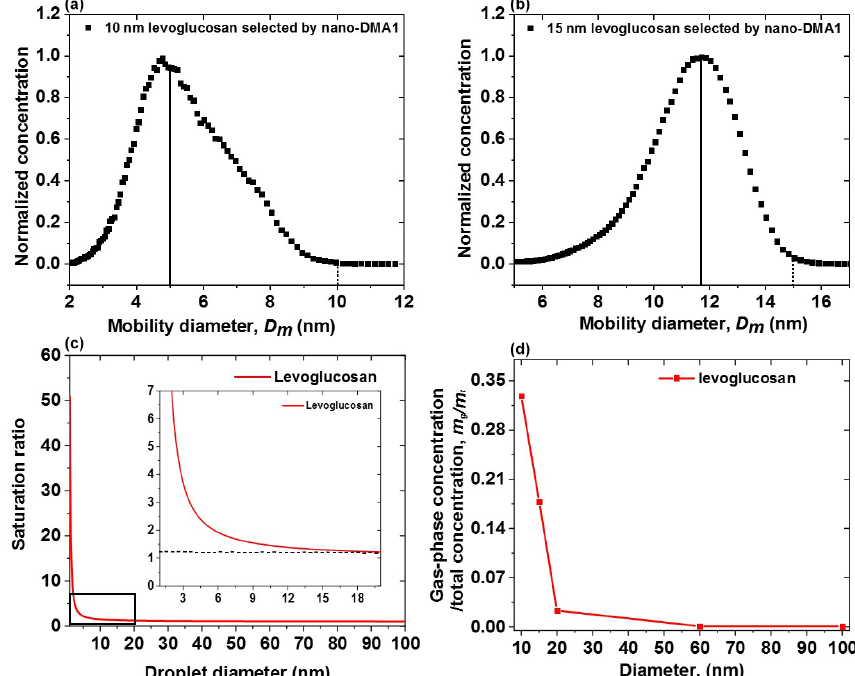
Figure 5. The normalized size distributions scanned by nano-DMA2 for (a) 10 and (b) 15nm levoglucosan at 10% at 298K. The dotted lines mark the diameters of the monodispersed nanoparticles selected by the nano-DMA1. The back solid lines mark the peak diameters from the normalized size distributions scanned by the nano-DMA2. (c) Vapor saturation ratio of levoglucosan as a function of nanodroplet diameter according to the Kelvin equation. The diameter range 1–20nm for the saturation ratio of levoglucosan particles is shown as an inset. The value of surface tension of pure levoglucosan is 0.0227104 [Jm − 2 ]. (d) The ratio of gas-phase concentration ( m g ) to the total concentration ( m t ) of levoglucosan nanoparticles against